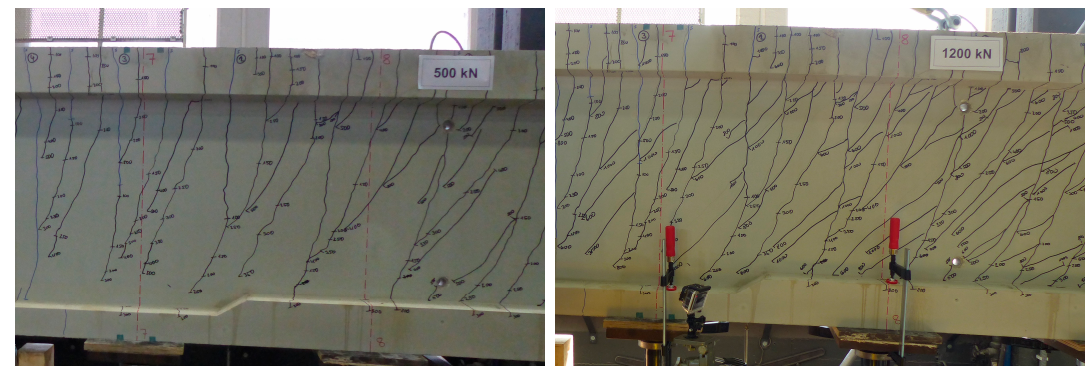
Figure 12. Change of inclination of bending-shear cracks at 500 kN and 1200 kN total load of specimen FT02.